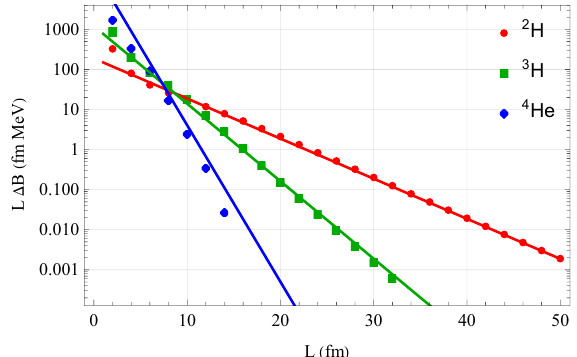
Figure 2. The energy shift ∆ B N due to the finite volume, multiplied by the box size L , as a function of L , for light nuclei using the Minnesota potential. Shown are results for deuteron (red), triton (green), and 4 He (blue). Symbols represent SVM results, and curves are the predictions of Lüscher-like formulae, Eq. (1,2) using free-space A N and κ N values.